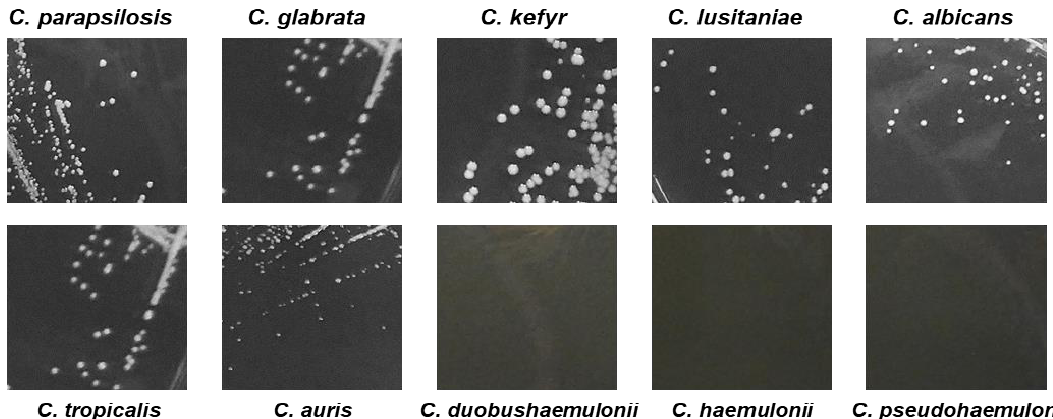
Figure 3. Pictures of Candida spp., colonies growth onto Sabouraud dextrose agar. C. auris exhibited smaller colony size compared to most Candida spp. after 24 h incubation time at 37 °C. Table 3. Average of colony size of Candida species grown at different temperatures.